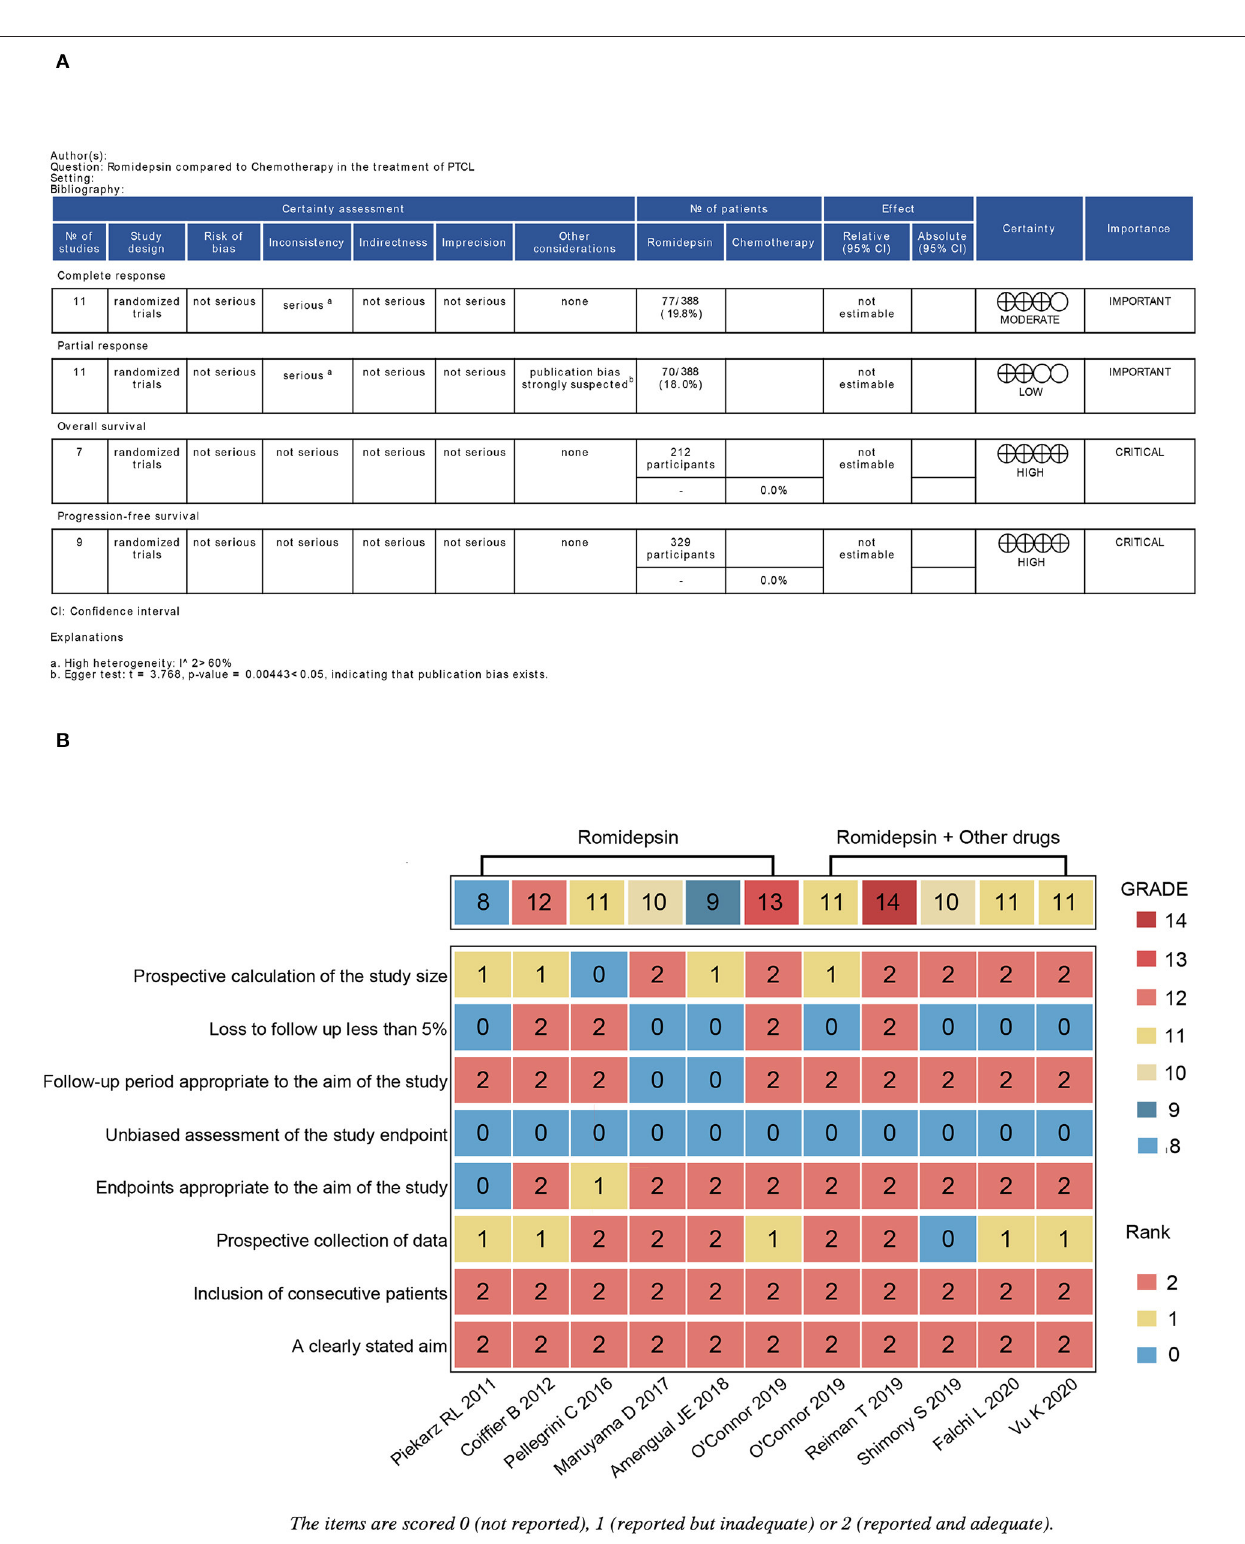
FIGURE 5 | Evaluation of the grade of outcomes and the quality of the included studies. (A) Grade analysis table of outcomes; (B) Heatmap plot of the quality evaluation for the included studies. The overall certainty of the evidence for outcomes was assessed by the Grading Recommendations Assessment, Development and Evaluation (GRADE)